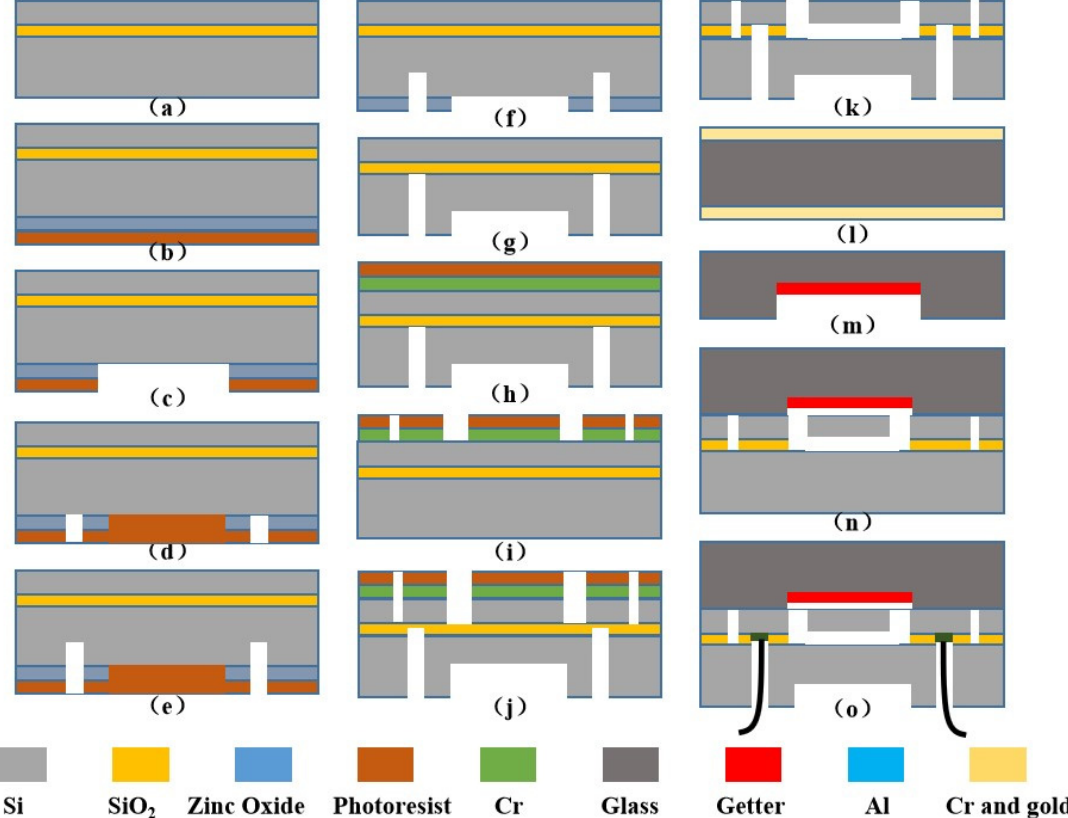
Figure 3. Fabrication process of the resonant pressure sensor: ( a ) thoroughly clean the SOI wafer; ( b ) sputter zinc oxide and spin coat photoresist on the back side of SOI wafer; ( c , d ) pattern the pressure-sensitive diaphragm and through-silicon vias; ( e ) etch the through-silicon vias to a certain depth; ( f , g ) etch the pressure-sensitive diaphragm and through-silicon vias simultaneously; ( h ) sputter Cr and spin coat photoresist as masks on the front side of SOI wafer; ( i , j ) pattern and fabricate the structure layer including resonators, excitation and detection electrodes; ( k ) release the resonators and remove the oxide on top of through-silicon vias; ( l ) sputter Cr and Au materials on both sides of glass; ( m ) process the glass cover with grooves followed by the deposition of getter materials using a hard mask after removing the Cr and Au materials; ( n ) conduct silicon-to-glass anodic bonding; ( o ) sputter Aluminum and form electrical connection.